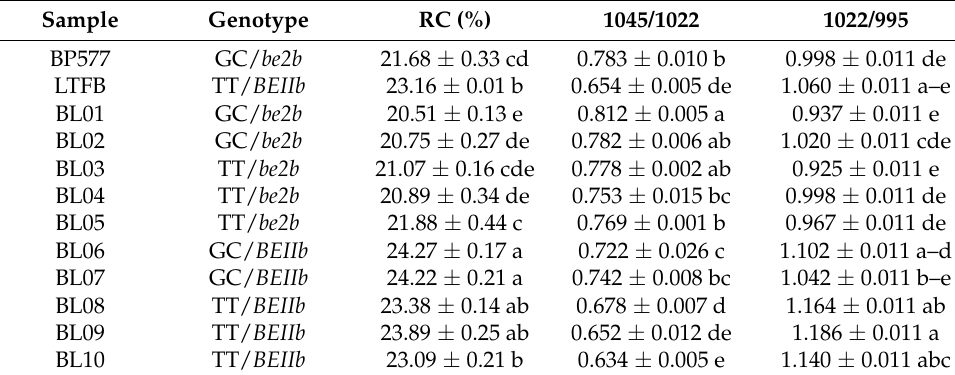
Figure 3. XRD spectra ( A ) and deconvoluted ATR-FTIR spectra ( B ) of rice starches. Table 3. Relative crystallinity and IR ratios of rice starches